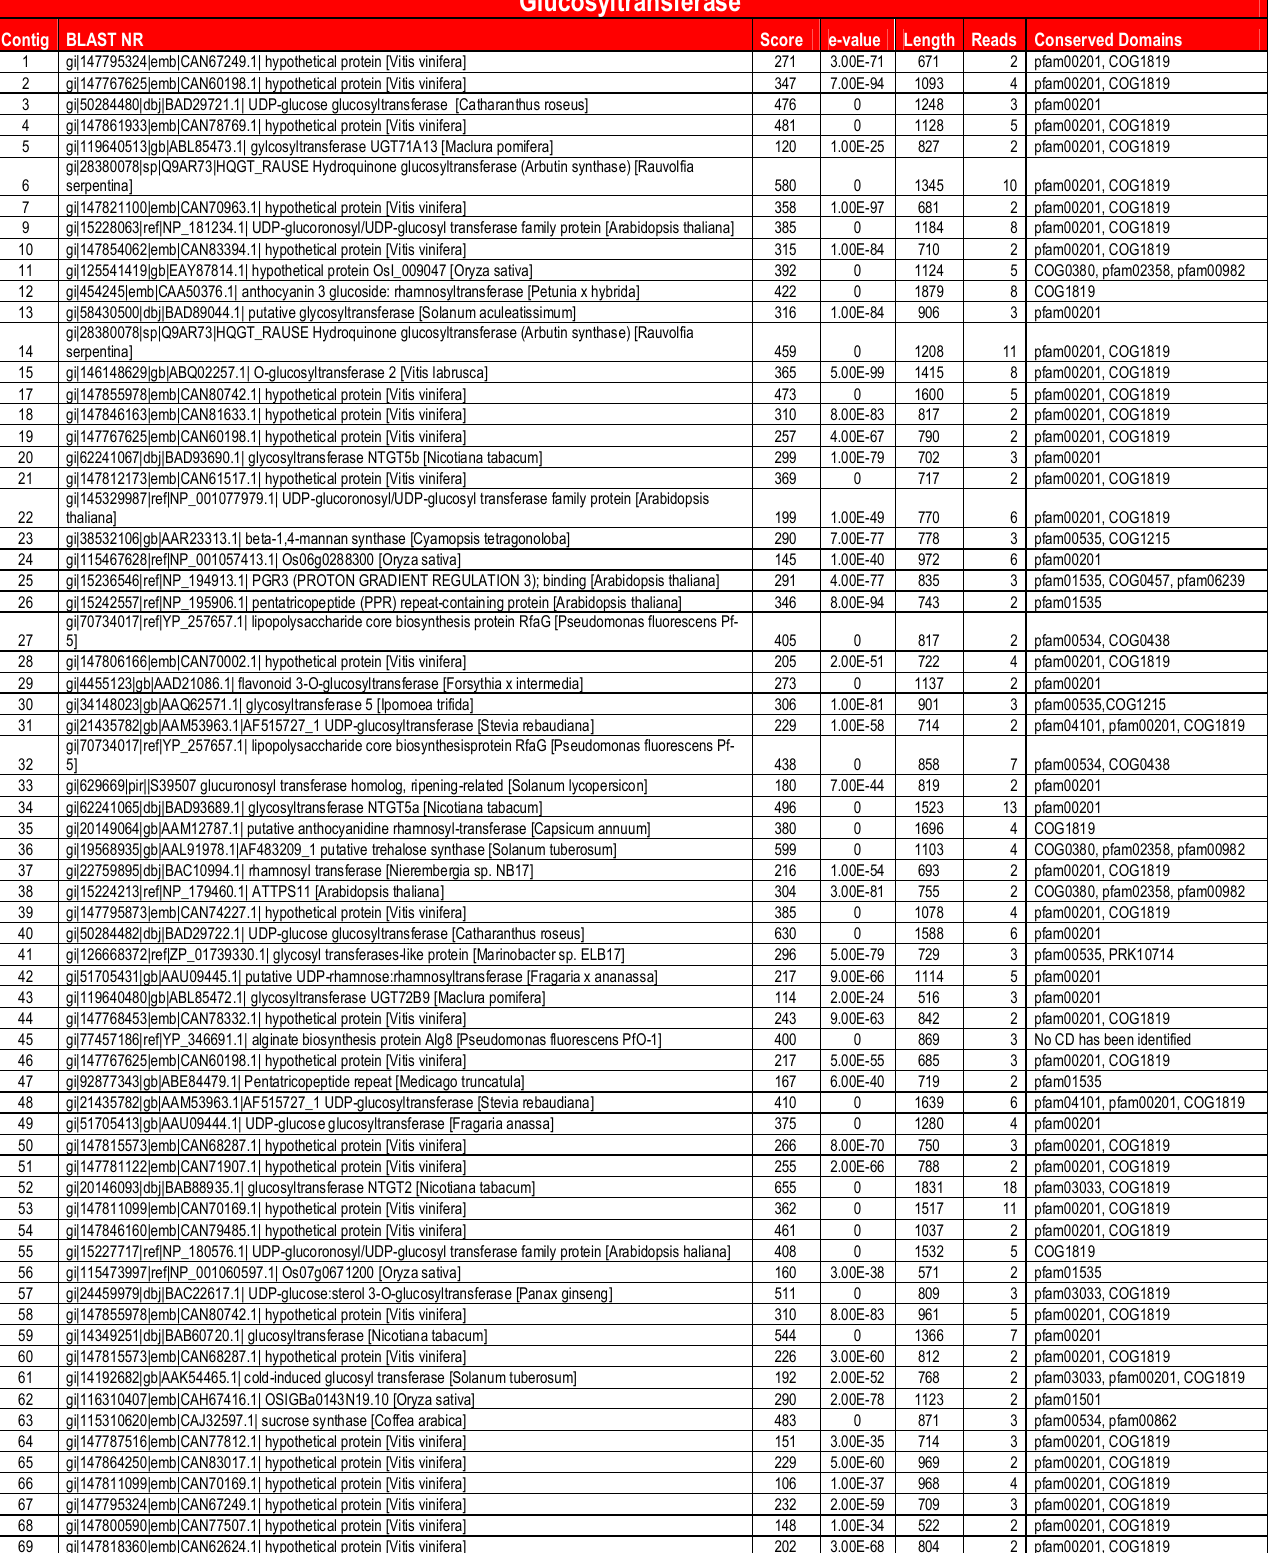
Table S14 : EST-Contigs with e-value < e -20 and score > 100 obtained in the Project Glucosyltransferase, and their blast hit, score, e-value, size, number of reads, and conserved domains from putative proteins. Glucosyltransferase Contig BLAST NR Score e-value Length Reads Conserved Domains 1 gi|147795324|emb|CAN67249.1| hypothetical protein [Vitis